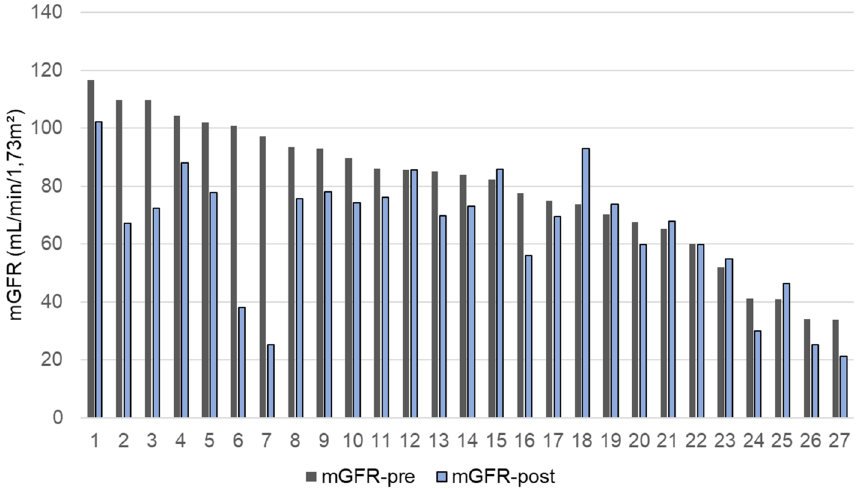
Figure 2. Individual evolution of measured glomerular filtration rate (mGFR in mL/min/1.73 m 2 ) before and 6 months after radical cystectomy and urinary diversion. Black bars: mGFR before surgery. Grey bars: mGFR after surgery. Dotted lines represents mGFR at 60 mL/min/1.73 m 2 (cut-off for chronic kidney disease definition) and at 30 mL/min/1.73 m 2 (cut-off between stages 3B and 4 for GFR